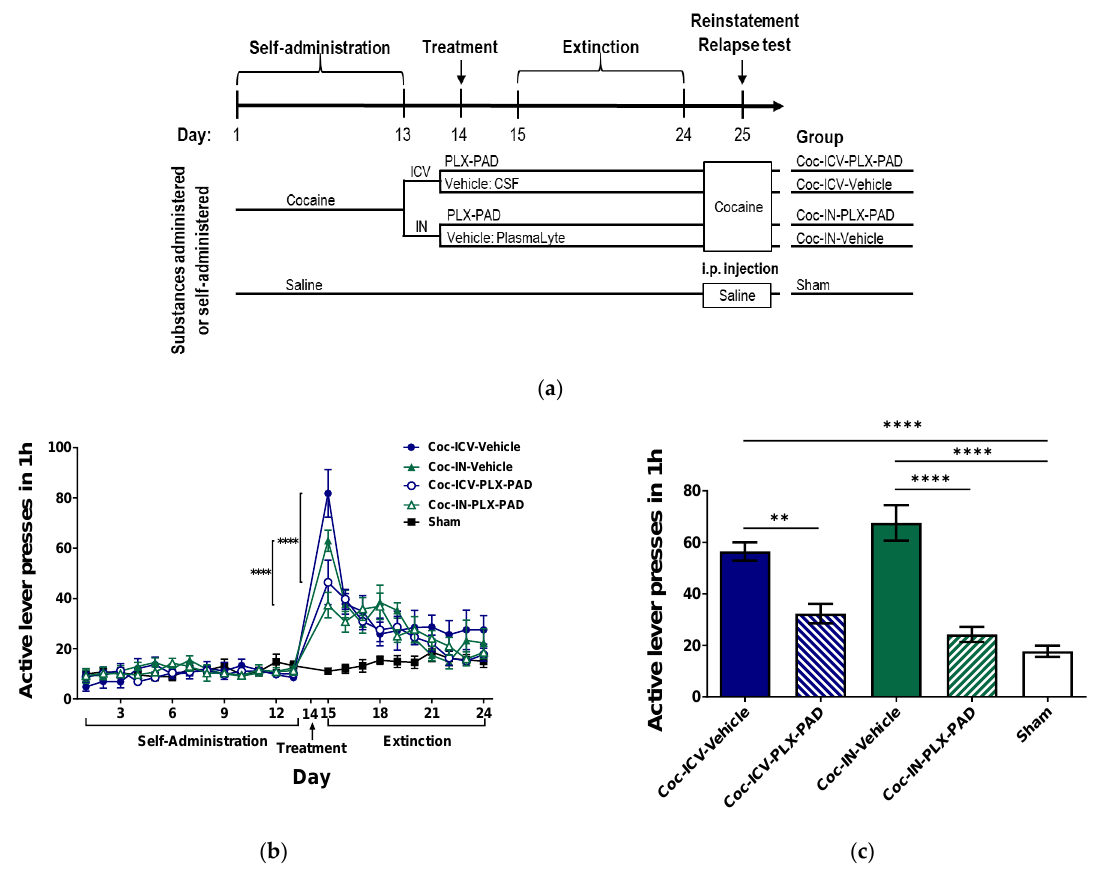
tiple comparison tests. On Day 15, the first day of the extinction phase, cocaine-trained rats treated ICV and IN with vehicle exhibited significantly more ( p < 0.0001) active lever presses than the ICV and IN PLX-PAD-treated groups, respectively, indicating higher craving for the drug. No significant difference was observed between PLX-PAD treatment delivered IN and ICV.